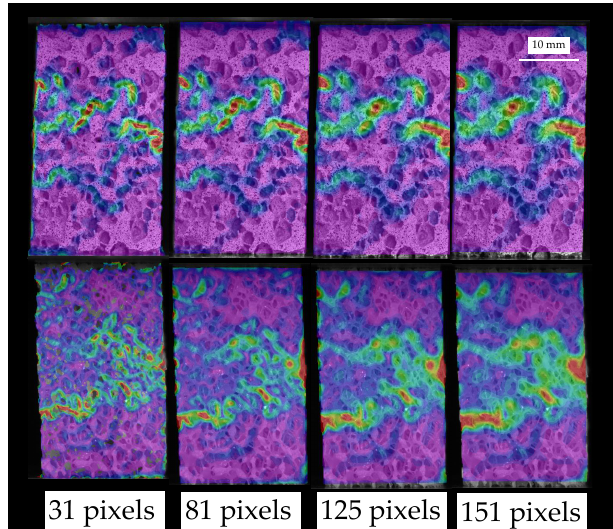
Figure 8. Subset size variation influence on the maximum equivalent strain measured in the failure region for HD ( top ), MD ( bottom ). The influence for LD specimens is very similar to the one depicted for the MD